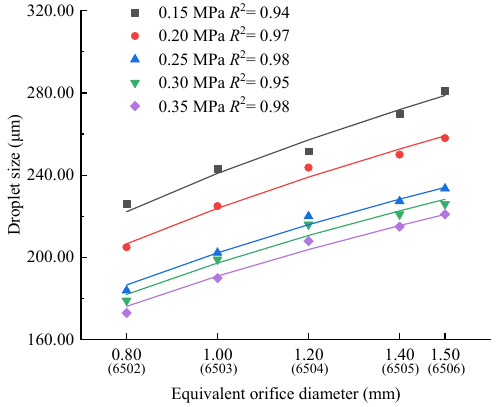
Figure 6. Fitting curves and values of droplet size vs. spray pressure: ( a ) different spray angles; and ( b ) different flow rates.